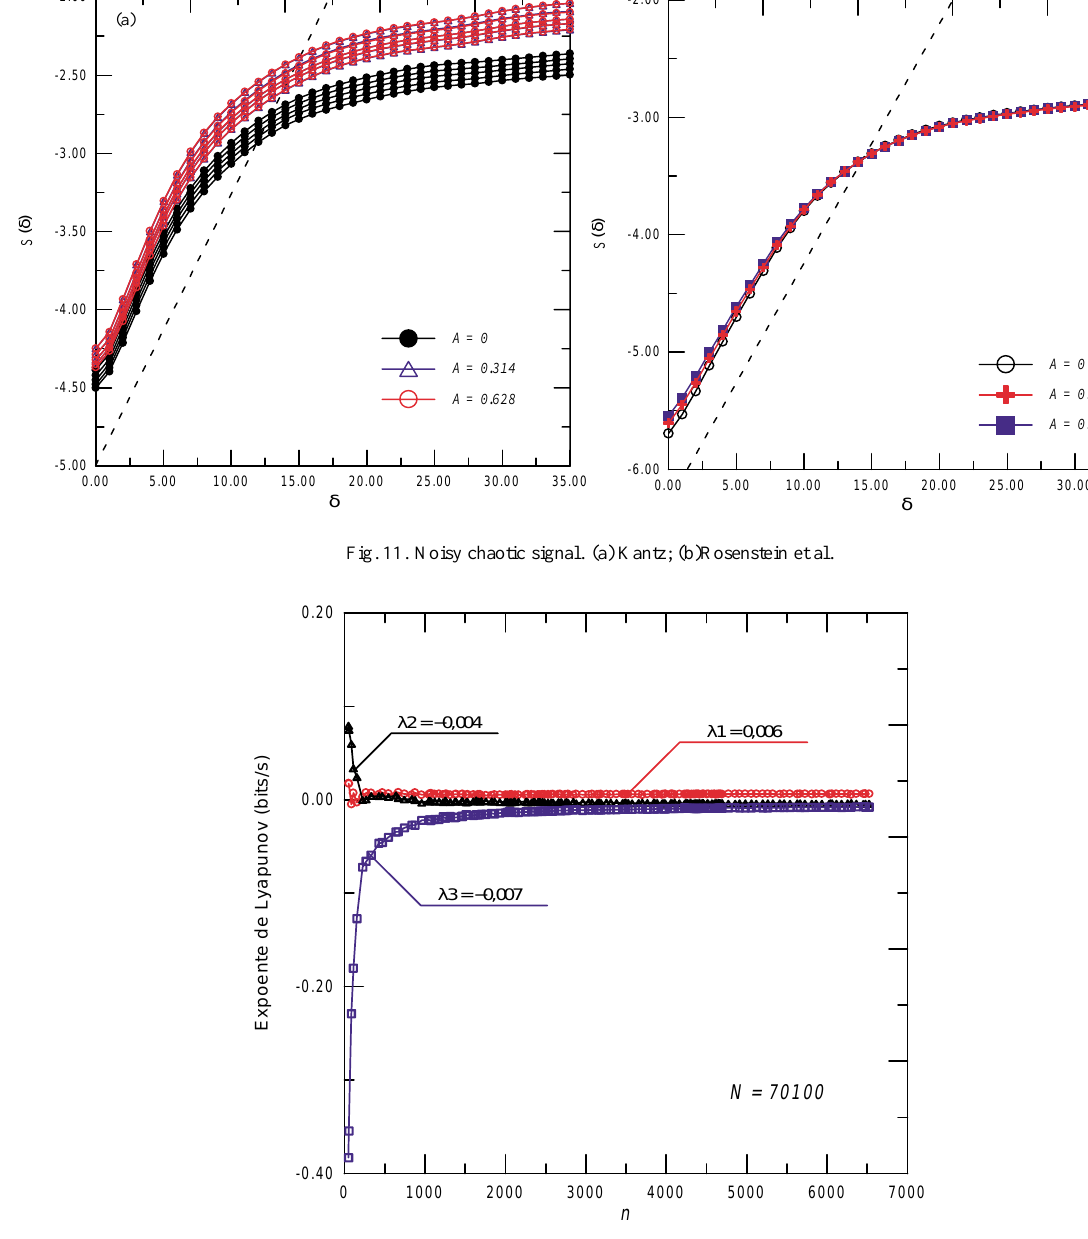
Fig. 12. Spectrum of Lyapunov exponents obtained from the algorithm due to Sano and Sawada: Ideal periodic signal ( A = 0 ). ξ , in a tangent space at s ( t ) , is represented by lineariz- ing the differential equation, ˙ ξ = Bξ , where B is the Jacobian matrix of f . The solution of this equation is expressed as ξ ( t ) = B t ξ (0) , where B t is the linear operator which maps tangent vector ξ (0) to ξ ( t ) . Sano and Sawada have established a procedure for estimat- ing a linearized flow map B t from the observed